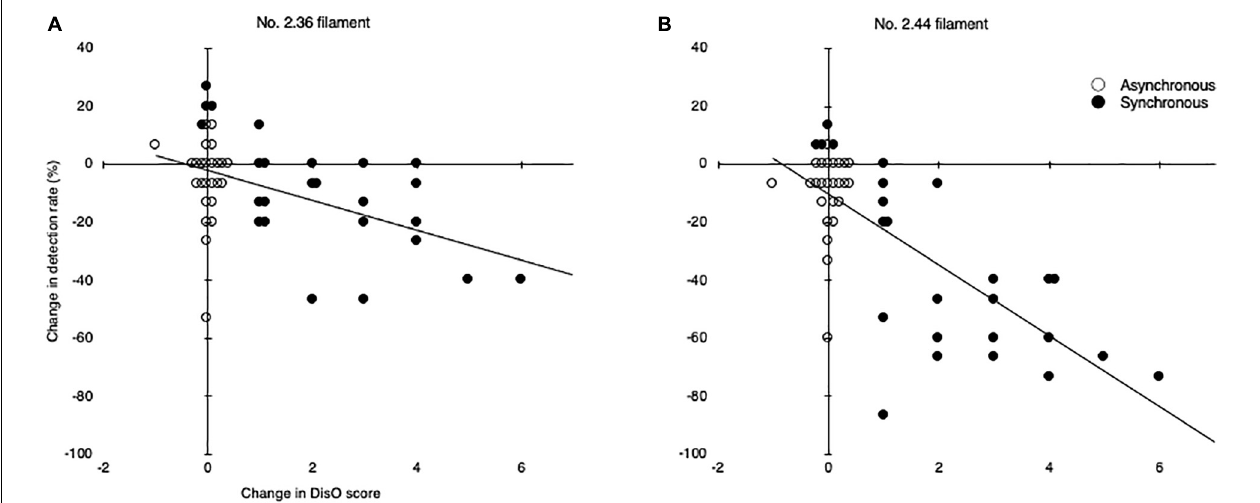
FIGURE 6 | Scatterplots of disownership-score changes and detection-rate changes. (A) The relationship between disownership-score (DisO) changes and detection-rate changes for the No. 2.36 filament in all conditions. (B) The relationship between disownership-score (DisO) changes and detection-rate changes for the No. 2.44 filament in all conditions. Data from 25 subjects are plotted. Closed circles indicate plots under the synchronous condition. Open circles indicate plots under the asynchronous condition. Trend-lines show significant negative correlations for both No. 2.36 filaments ( ρ = − 0.478, p < 0.0005) and No. 2.44 filaments ( ρ = − 0.713, p <